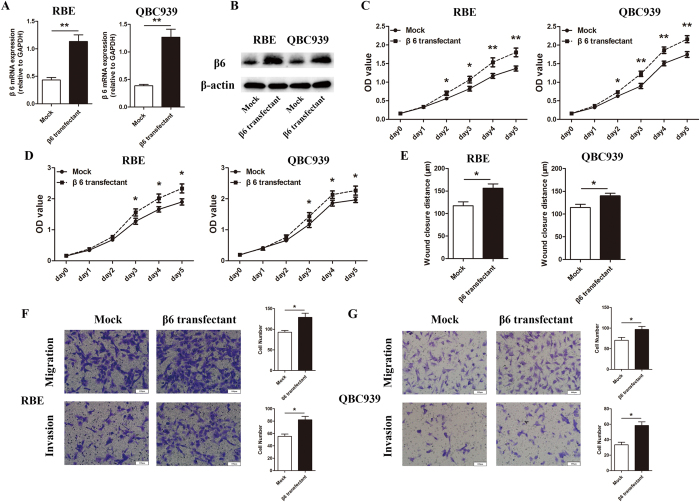
β6 overexpression markedly promoted the proliferation, migration and invasion of cholangiocarcinoma cells.(A) Real-time PCR showed that integrin β6 expression was significantly upregulated after transfection of the β6 overexpression plasmid. (B) Western blotting showed that β6 expression was significantly increased after transfection with the β6 overexpression plasmid in RBE and QBC939 cells at the protein level. (C) CCK8 assays revealed that overexpression of β6 significantly promoted cell viability in RBE and QBC939 cells. (D) After β6 overexpression, MTT assays were conducted to evaluate the proliferation of RBE and QBC939 cells. (E) RBE and QBC939 cells transfected with the β6 overexpression plasmid were used for wound-healing assays. (F,G) RBE (F) and QBC939 (G) cells transfected with the β6 overexpression plasmid were used for Transwell migration assays and invasion assays. Five fields of cells were counted in the lower chambers (×200 magnification). Data represent the mean ± SD of three independent experiments. *P < 0.05; **P < 0.01.